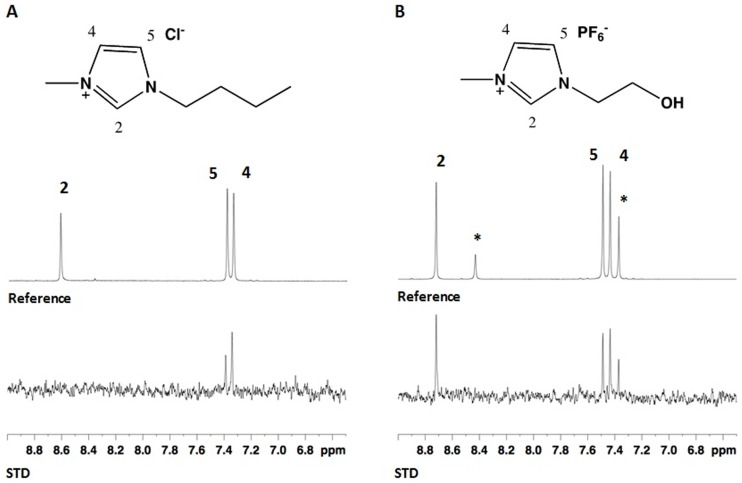
Expansion of the aromatic region of (A) the reference and the STD NMR spectrum obtained with [C4mim]Cl and (B) the reference and the STD NMR spectrum obtained with [C2OHmim]PF6.*Marks the peaks of imidazole present in the protein sample.